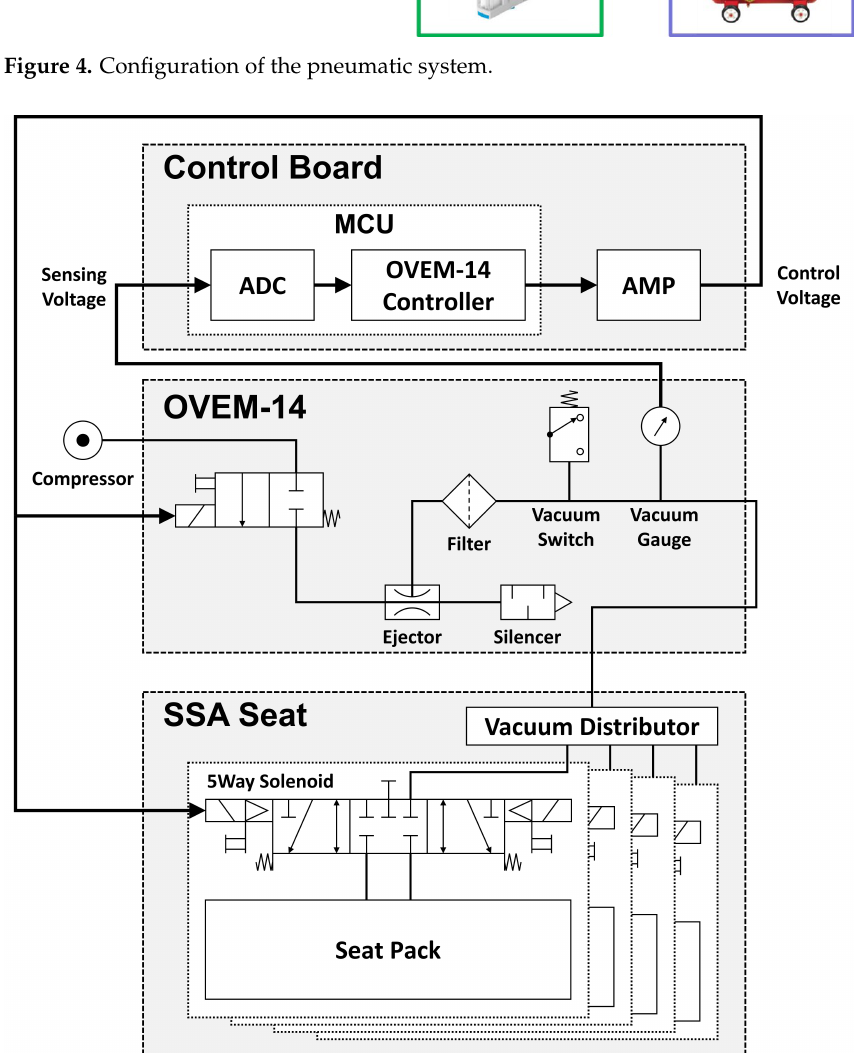
Figure 5. Pneumatic circuit block diagram of SSA